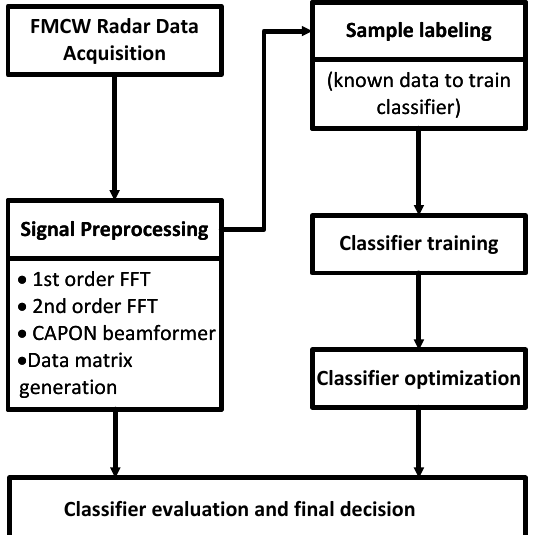
Figure 1. Data collection, preprocessing, training, and evaluation process of the proposed hand gesture recognition framework for FMCW